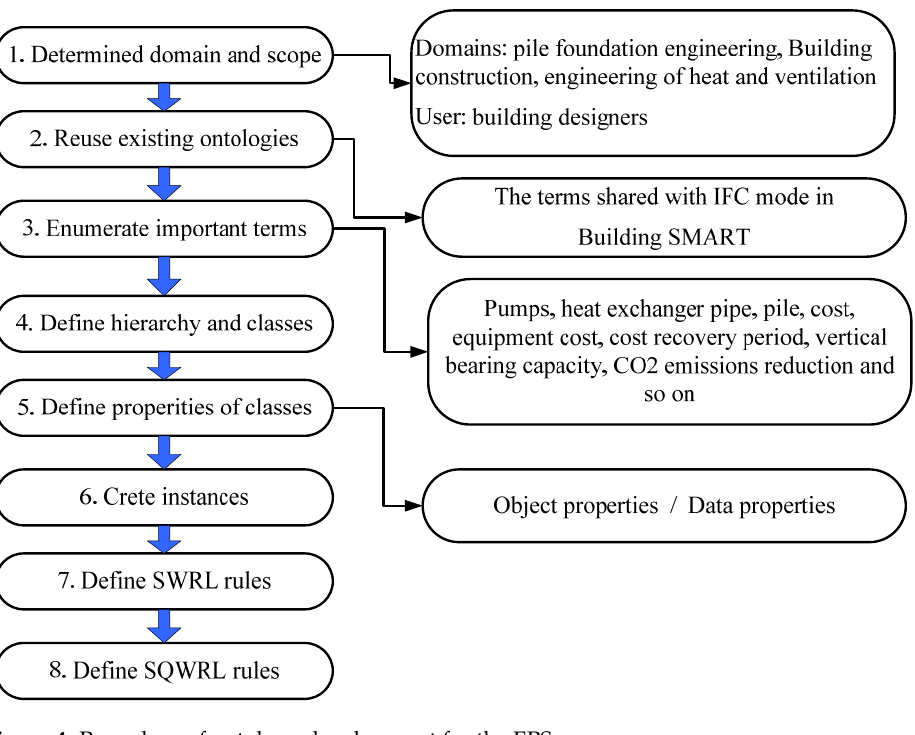
Figure 4. Procedure of ontology development for the EPS.